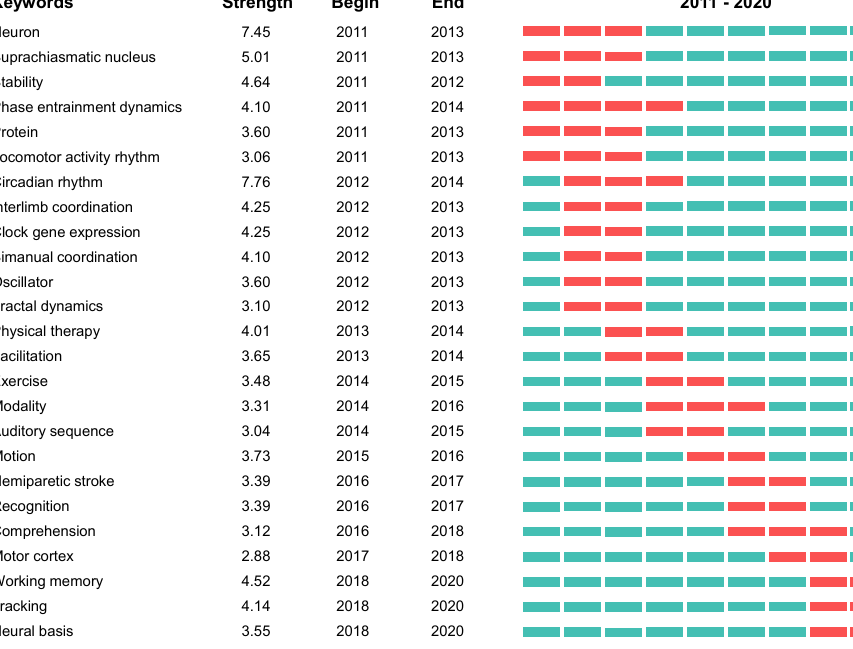
Figure 5. Keywords with the strongest citation bursts of publications on rhythmic auditory stimu- lation research. Alt text: The top 25 keywords with the strongest citation bursts of publications on rhythmic auditory stimulation research among 2011–2020. Working memory, tracking, and neural basis were the most recent three.